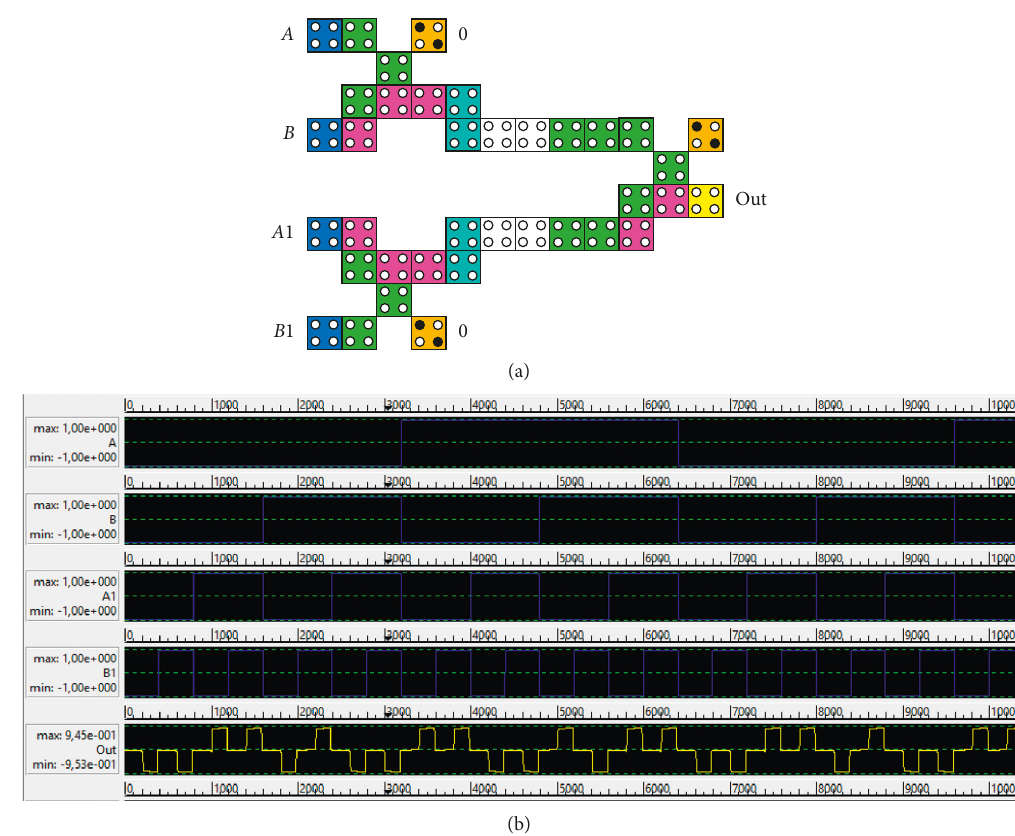
Figure 7: QCA layout of the designed (a) 4 bit parity generator and (b) simulation outcomes.